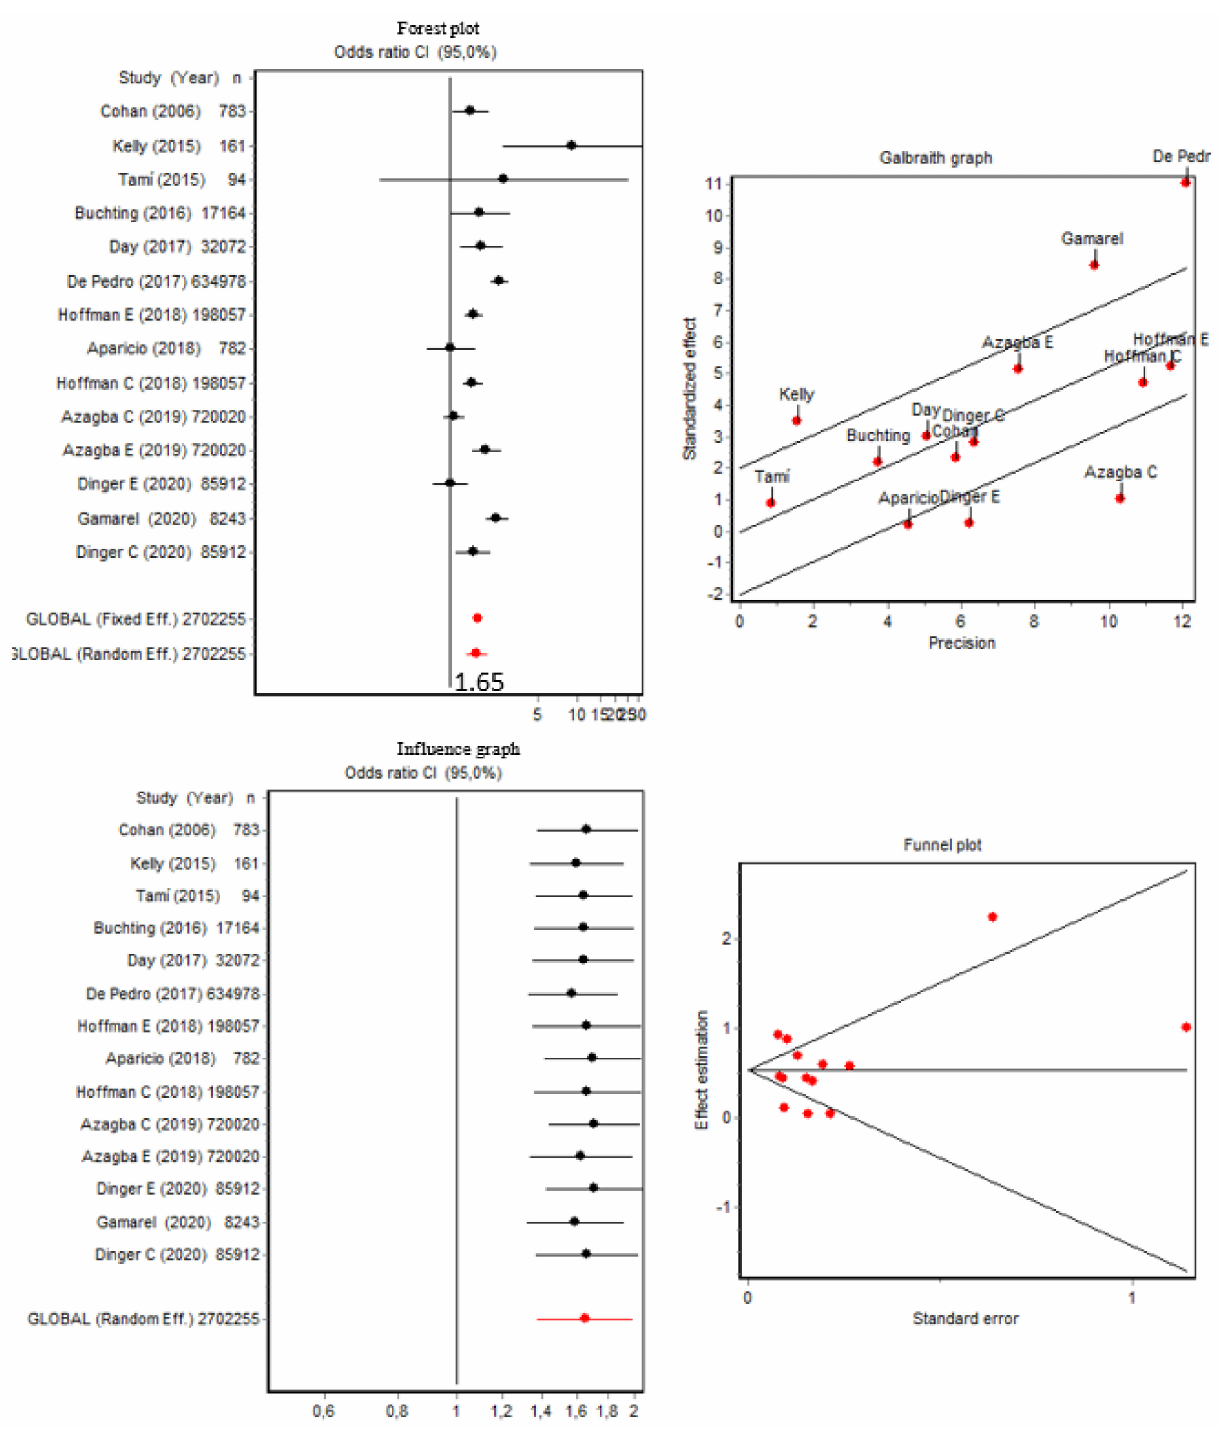
Figure 2. Forest plot, Galbraith graphic, influence graphic, and funnel plot for current tobacco use. Abbreviations: C, cigarettes; E,